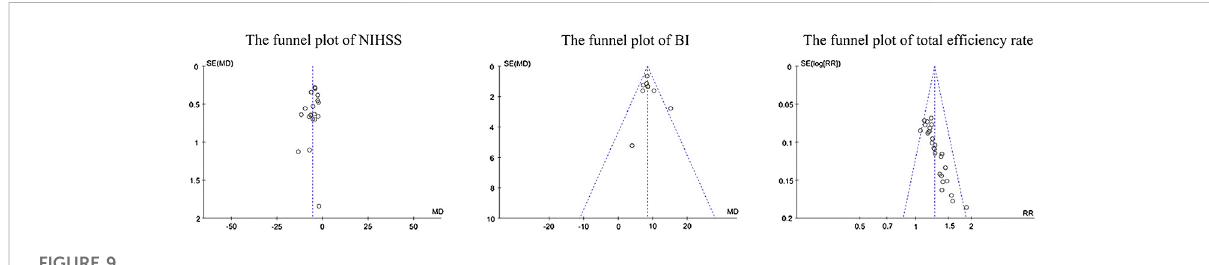
FIGURE 9 Funnel plots of the NIHSS score, BI, and total ef fi ciency